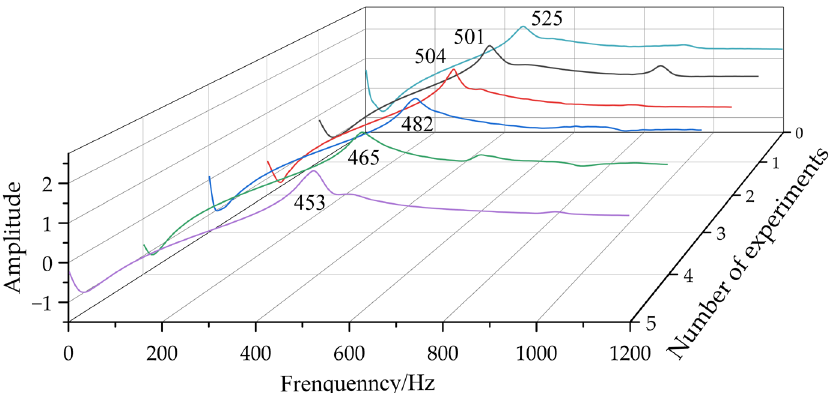
Figure 12. Frequency response functions in different milling stages.